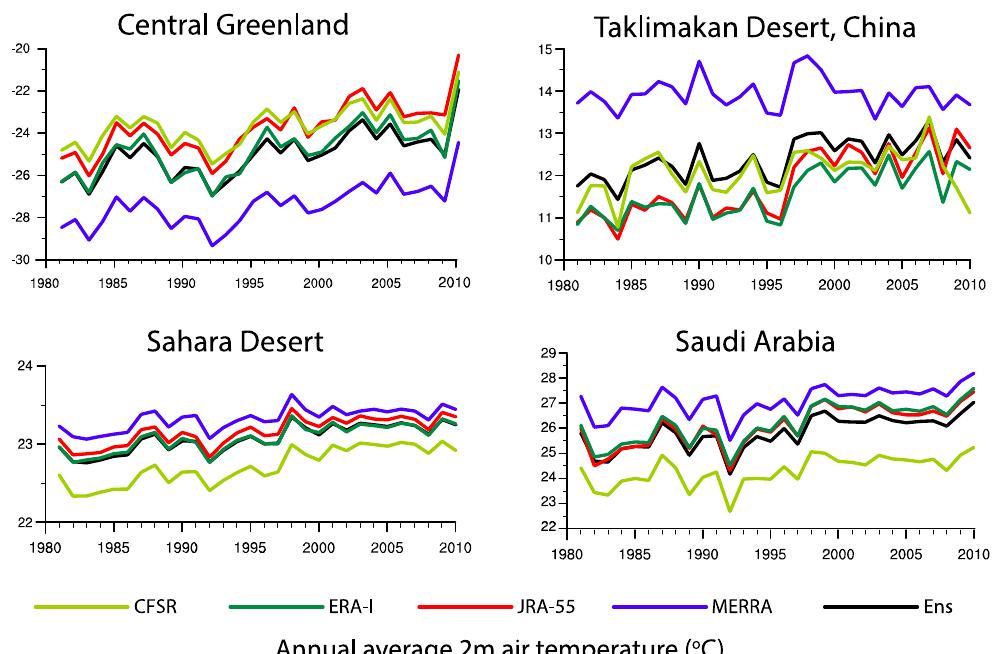
Figure 3. Time series of each member and ensemble mean (Ens) of annual 2-m air temperature averaged over the 1981–2010 period. Locations shown as black boxes in Figure 2.